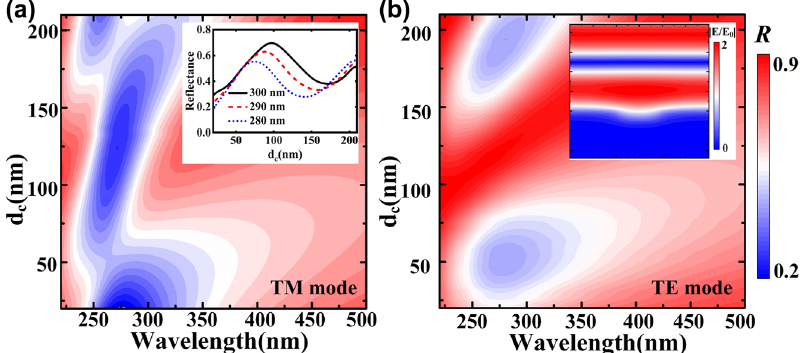
Figure 2: Trend of reflection with the equilibrium position and wavelength of graphene, (a) TM mode, the system reflection changes with distance when the wavelength is 280, 290, and 300 nm, respectively. (b) TE mode, the illustration shows electric field